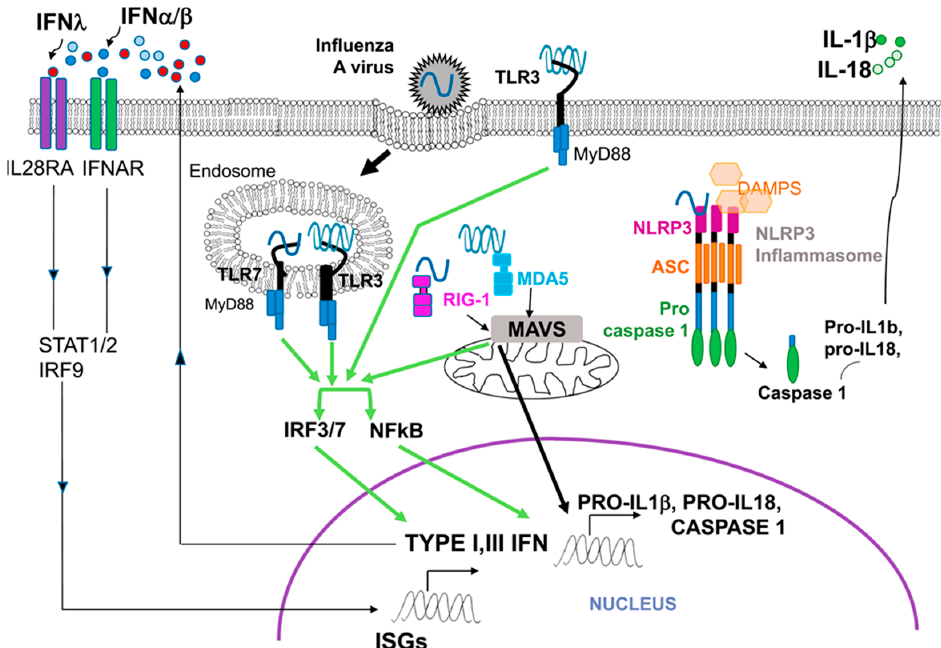
Figure 2. Principal Innate Immunity Signaling Pathways in Influenza A Virus Infection Viral RNA (a PAMP) in the endosome is sensed by the PRRs TLR3 and TLR7, and on the cell surface by TLR3. Viral RNA in the cytoplasm is recognized by the PRRs RIG-I and MDA-5, which then interact with the mitochondrial protein MAVS. These interactions between PAMPs and PRRs activate the transcription factors NF- κ B and the interferon regulatory factors IRF3 and IRF7 to promote transcription of genes for the synthesis of type 1 ( α , β ), type 3 ( λ ) IFNs, and pro-inflammatory proteins. The IFNs bind to the infected epithelial cell’s own IFN receptors or IFN receptors on nearby cells to cause the synthesis of proteins from many interferon-stimulated genes (ISGs) that inhibit virus function in several ways. In parallel, cytosolic viral RNA and DAMPs interact with NLRP3 of the inflammasome complex to activate caspase-1 and produce the inflammatory cytokines IL-1 β and IL-18. Reproduced as permitted under the creative commons license from Reference